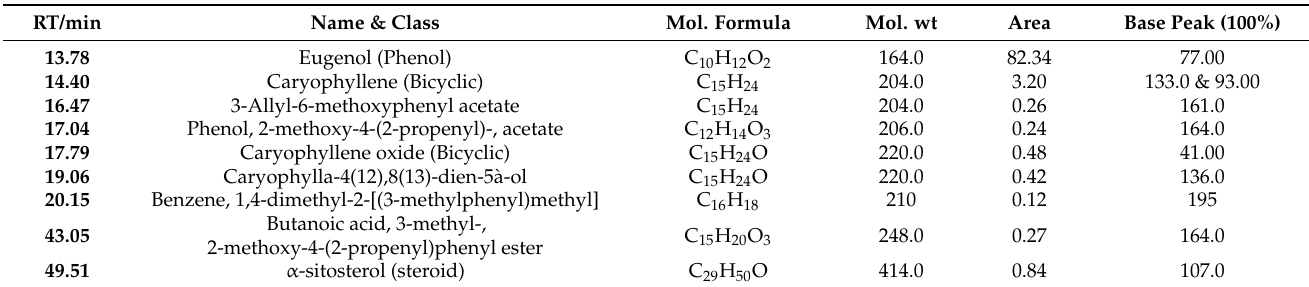
Table 3. GC-Mass analysis report for the clove ethanolic